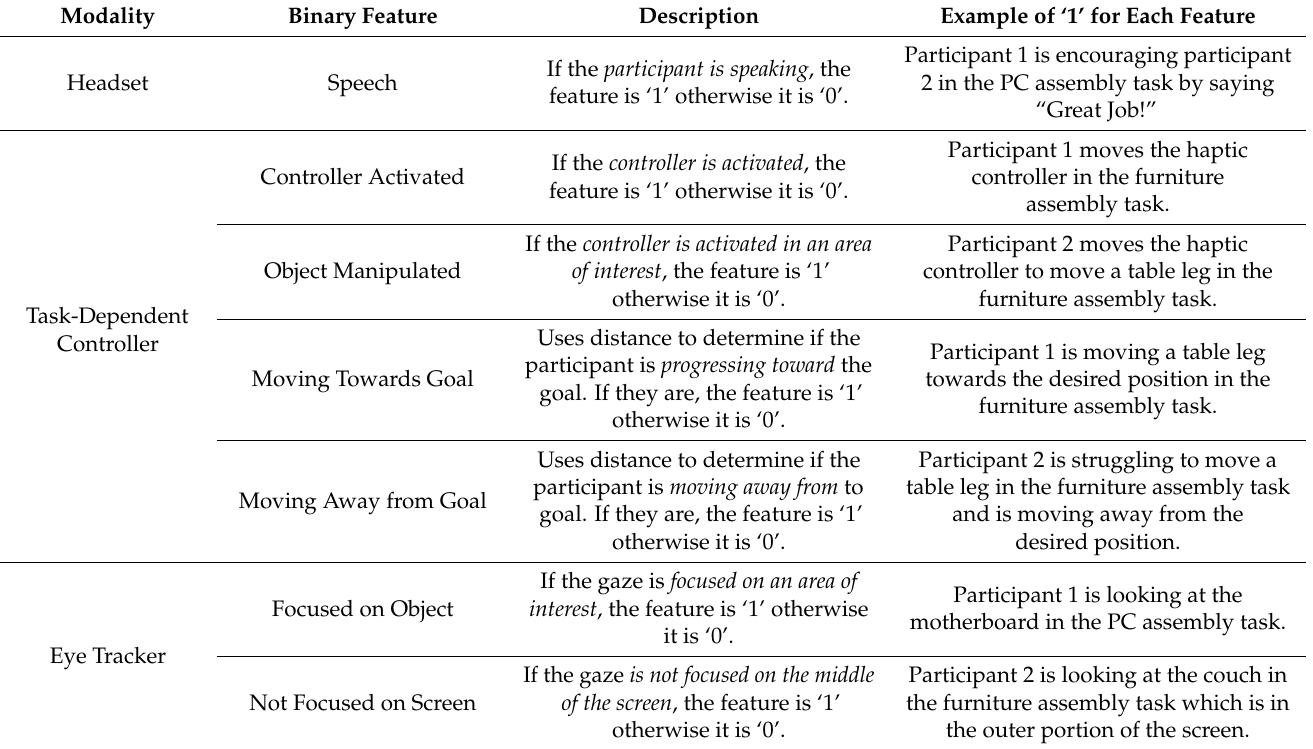
Figure 2. Experimental setup for data collection. Table 3. Features extracted from multimodal data with descriptions and examples.